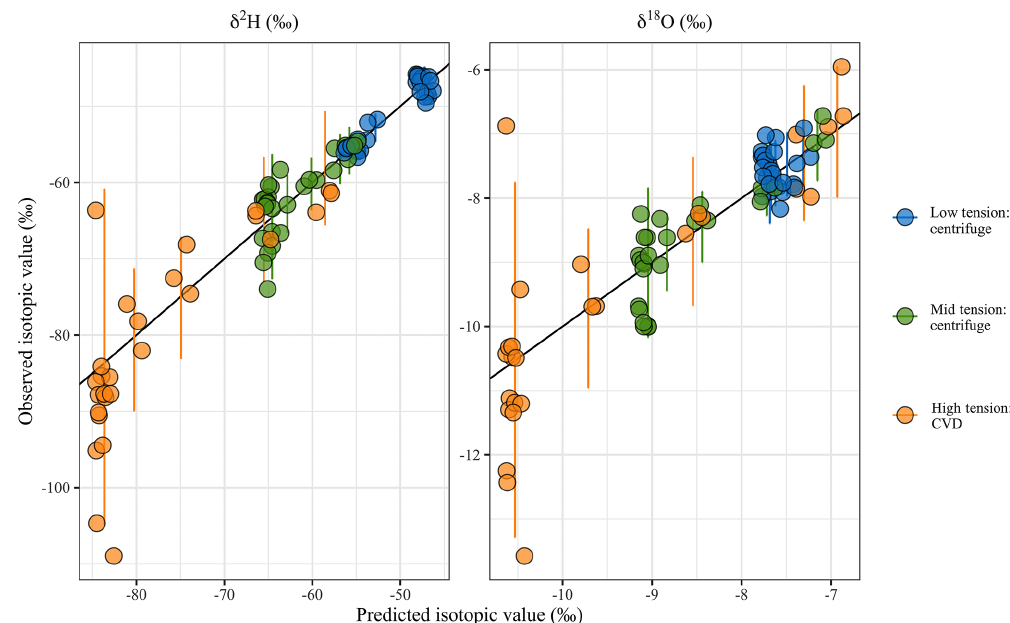
Figure 7. Comparison of predicted, with Eq. (3), and observed values for waters extracted with different tensions. The 1 : 1 line is shown. Bars represent the credible interval (90%) of the predicted values by time point and tension. A slight jitter (3%) has been added to the predicted value ( x axis) in an effort to display the points. Table 3. Means and standard deviations of parameters used in the time-dependent mixing